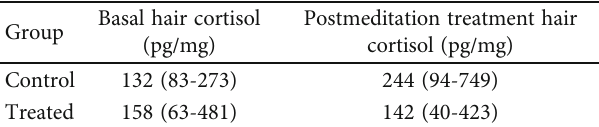
Table 3: Hair cortisol levels in studied population. Data are presented as median and range between minimum and maximum, n = 22